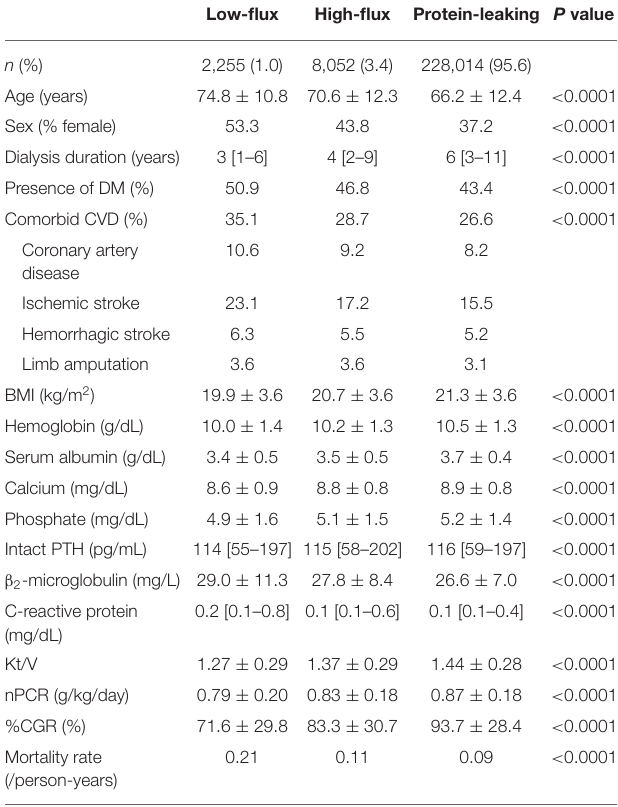
TABLE 2 | Demographic, clinical, and laboratory values in 238,321 hemodialysis patients according to dialyzer type in the international classification.